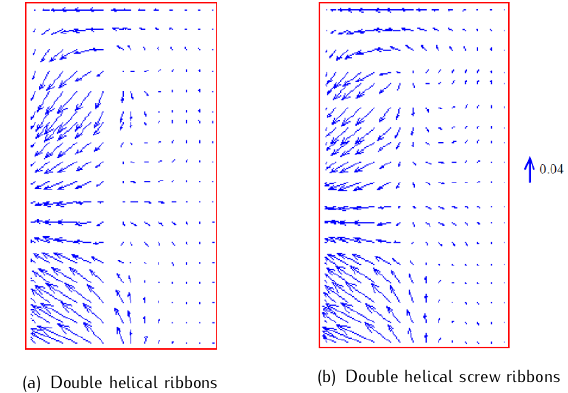
Figure 3. Flows patterns induced in r-z plane defined by